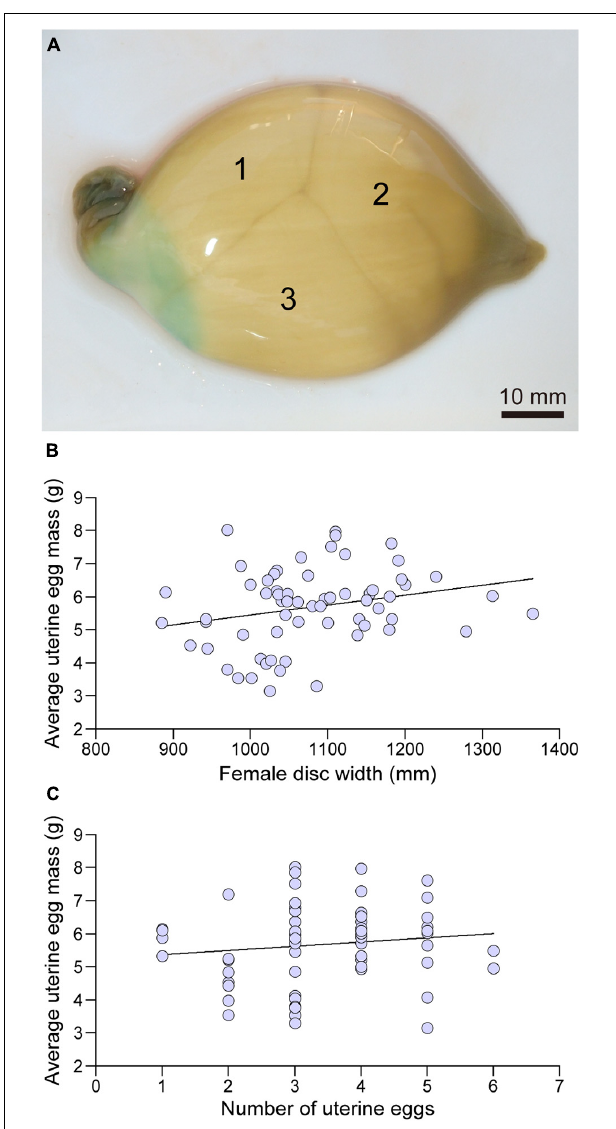
FIGURE 7 | A uterine egg case collected in October containing three eggs (A) , the relationship between the disc width (mm) and average uterine egg mass (g) (B) , and the relationships between number of eggs in the egg case and average uterine egg mass (g) (C)